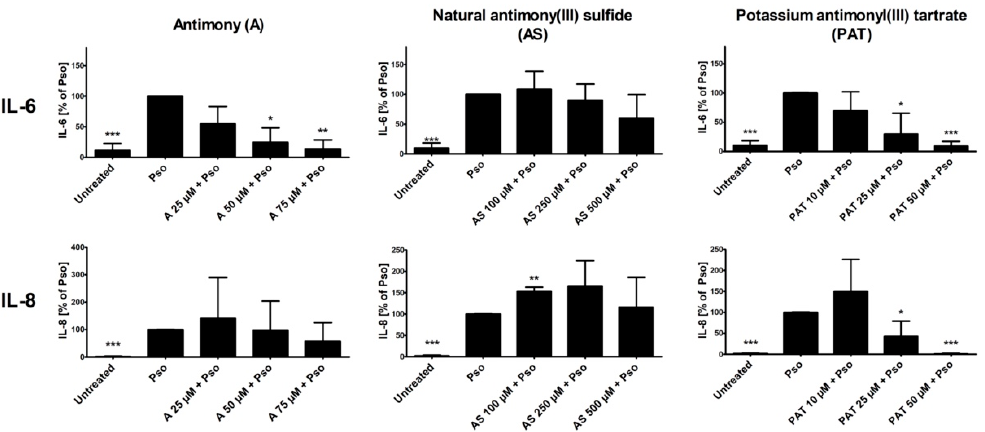
Figure 4. Effect of ACs on Pso-induced secretion of IL-6 and IL-8. PHKs were treated with Pso (20 ng/mL of IL-17A, IL-22 and TNF- α ) for 24 h with or without 2 h pre-treatment with A, AS or PAT. Afterwards, cell culture supernatant was collected and secretion of IL-6 and IL-8 were measured using ELISA. Results of four independent experiments are shown as mean ± SD. Statistics analysis was performed using column statistics with one-sample t -test comparing the samples to Pso stimulation. * p ≤ 0.05, ** p ≤ 0.01, *** p ≤ 0.001.